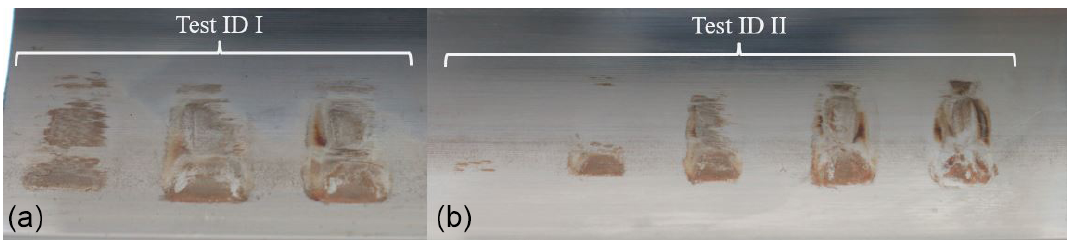
Figure 6. Three wear marks obtained with contact pressures of 2.5GPa in Test ID I (a) ; five wear marks obtained with contact pressures of 2.0GPa in Test ID II (b) .